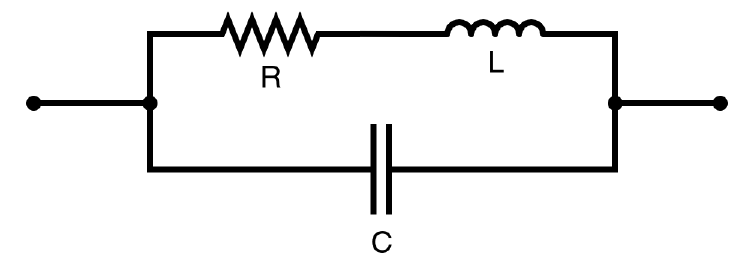
Figure 2. Equivalent circuit used to describe the behaviour of the